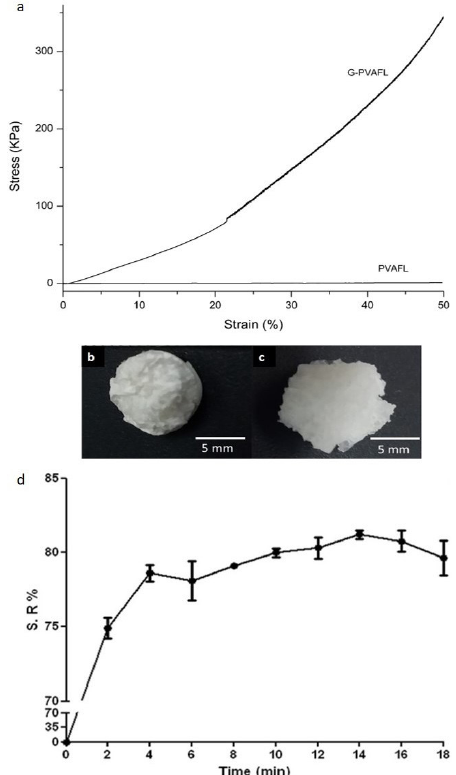
Figure 3. a. Stress-strain compression curves obtained for PVAFL and G-PVAFL; b-d. Macroscopic view in dry (b) and after 24 hours of water uptake (c) conditions of G-PVAFL. (d) Swelling rate of G-PVAFL.